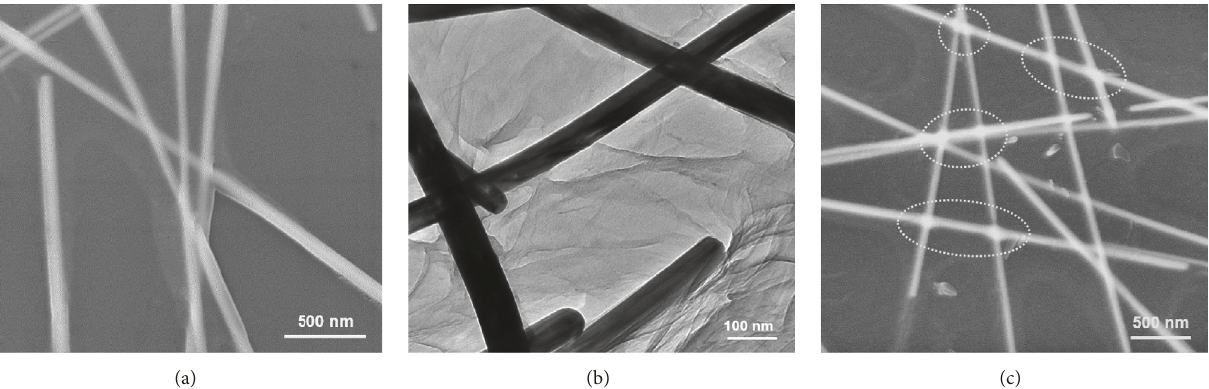
Figure 5: SEM image (a) and TEM image (b) of Ag NWs/GO composite films without treatments and SEM image of composite film treated by hot pressing